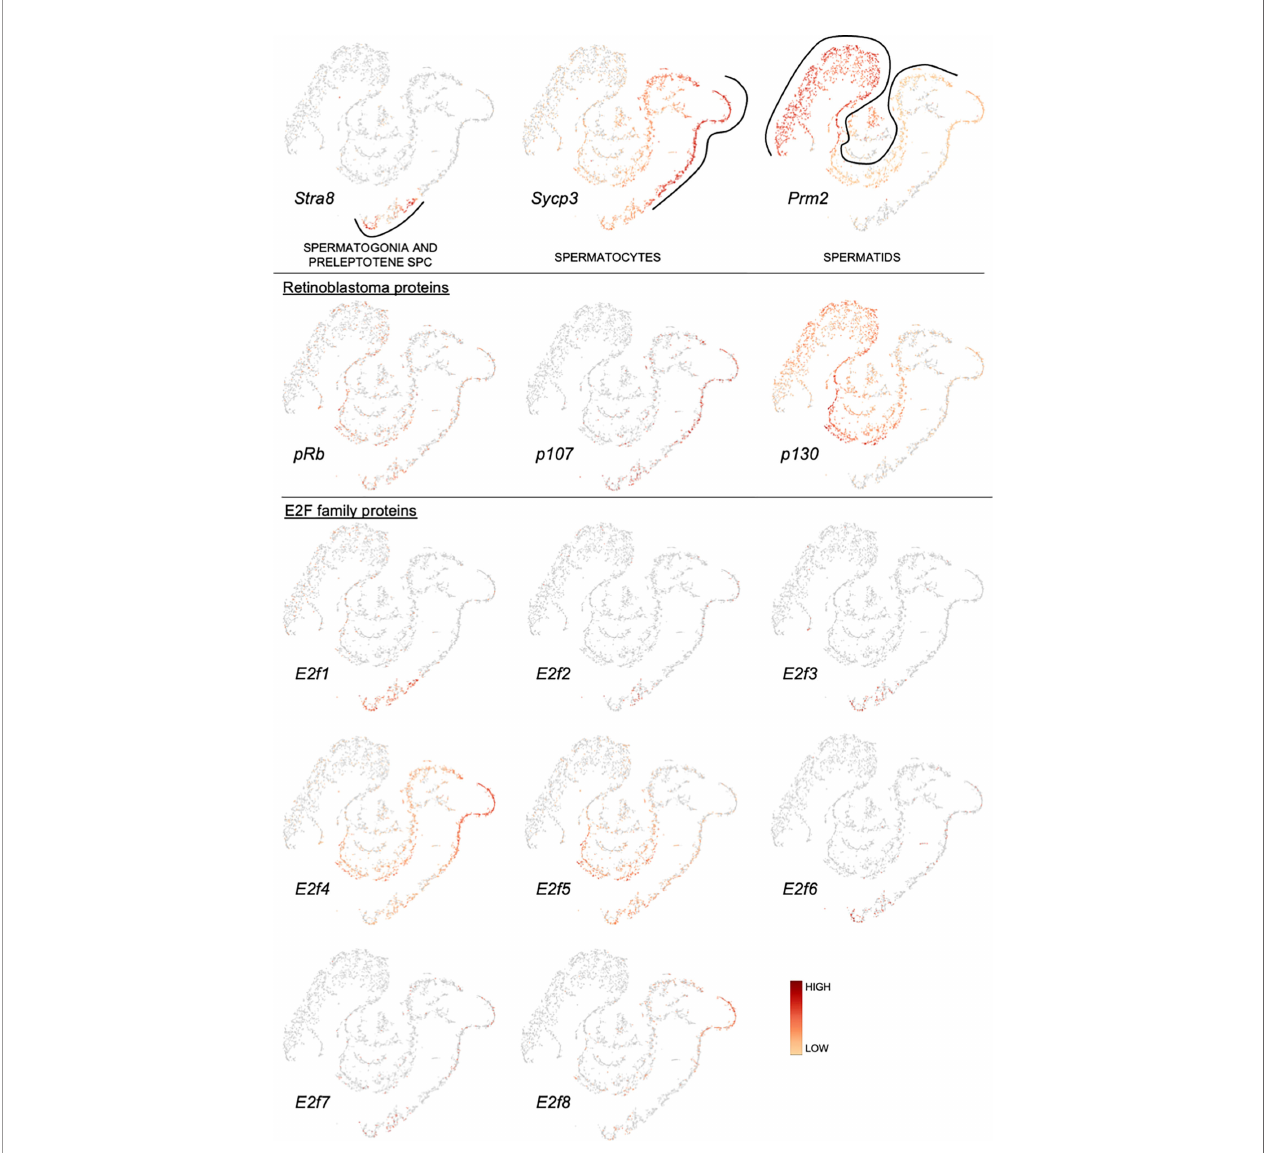
FIGURE 2 | Expression of retinoblastoma protein family and E2F transcription factor family mRNAs along a pseudotime trajectory of adult mouse spermatogenic cells. The data is extracted from Hermann et al. 2018 (26) using Loupe Cell Browser v6.0.0 from 10x Genomics. Stra8 , Sycp3 and Prm2 are included to denote spermatogonia/preleptotene spermatocytes, spermatocytes and spermatids,